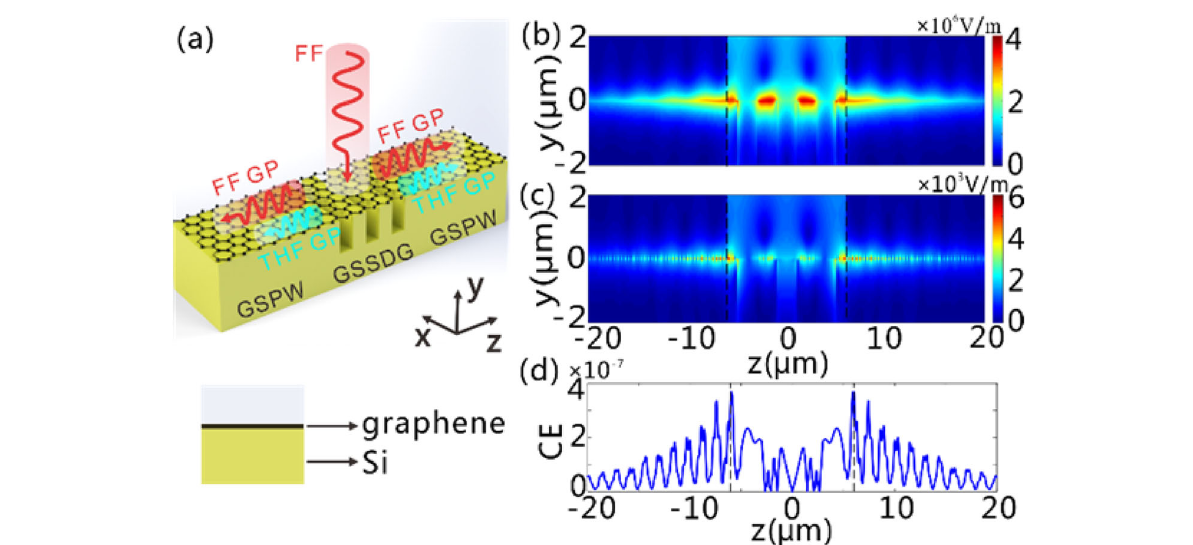
Fig. 5 Generation of FF and THF GPs on the GSSDG and the connected GSPWs. a The schematics of the GSSDG and the connected GSPWs on both sides when a normal-incidence x-polarized plane wave of FF illuminates the structure. The THF GPs are generated and guided along the two GSPWs after the FF GPs are excited in the GSSDG. The cross section of the GSPW is presented in the panel below, in which the graphene sheets and Si layer are denoted. b , c The | E | distributions of b FF and c THF GPs in the y - z plane as the grating section is illuminated by CW light with the power density of 0.19 MW/cm 2 at 28.62 μ m. d The CE of THG along the z direction. The black dashed lines in b – d represent the interfaces between the GSSDG and GSPWs. In b – d , N p is set at